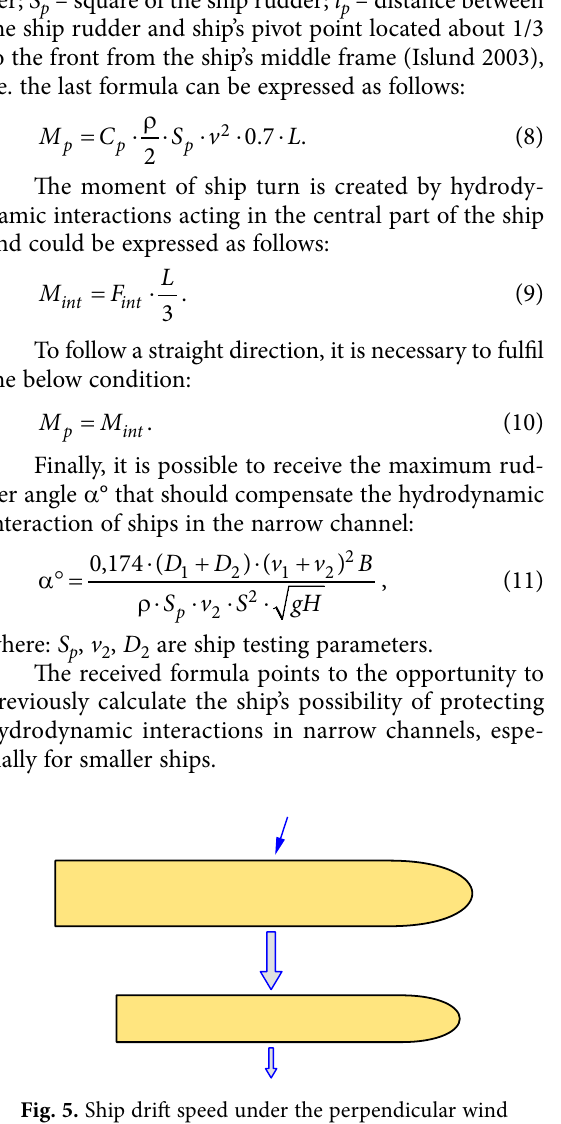
Fig. 5. Ship drift speed under the perpendicular wind direction to ships